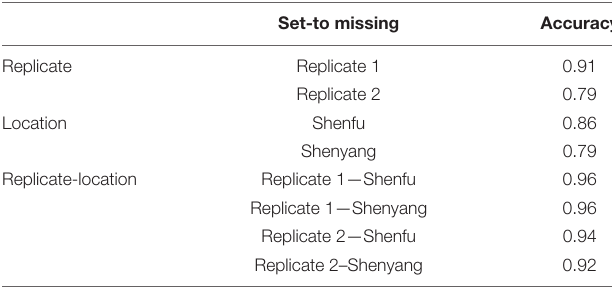
TABLE 3 | Prediction accuracy from the CV3 scenario for the temperate zone. Set-to